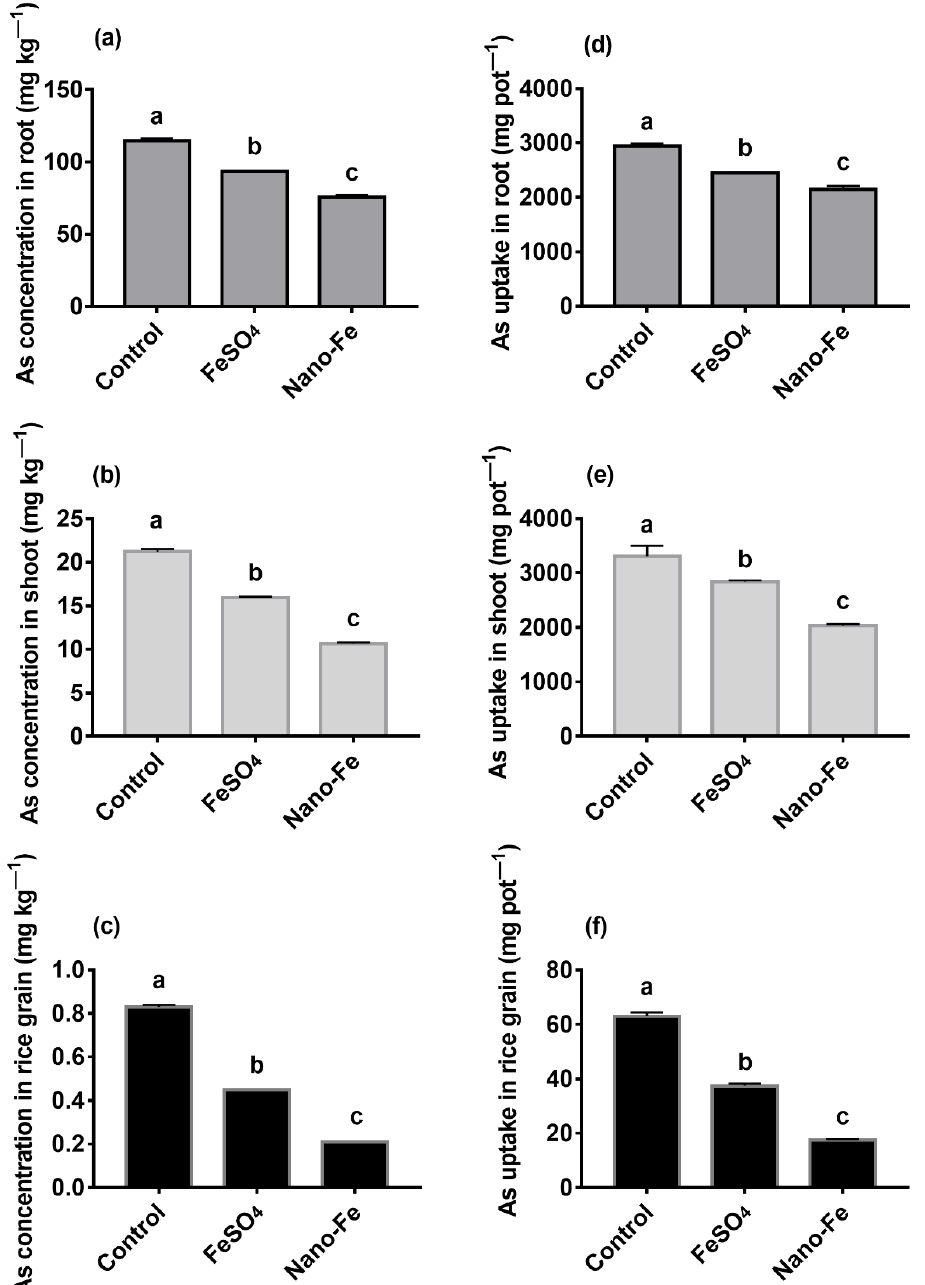
Figure 3. Concentrations of As in the roots ( a ), shoots ( b ), grains ( c ), and uptake of As in the roots ( d ), shoots ( e ), grains ( f ) of rice derived from treatments with exogenous Fe applied as FeSO 4 or Nano-Fe. Different lowercase letters in the columns indicate a significant difference among the different treatments at p < 0.05.